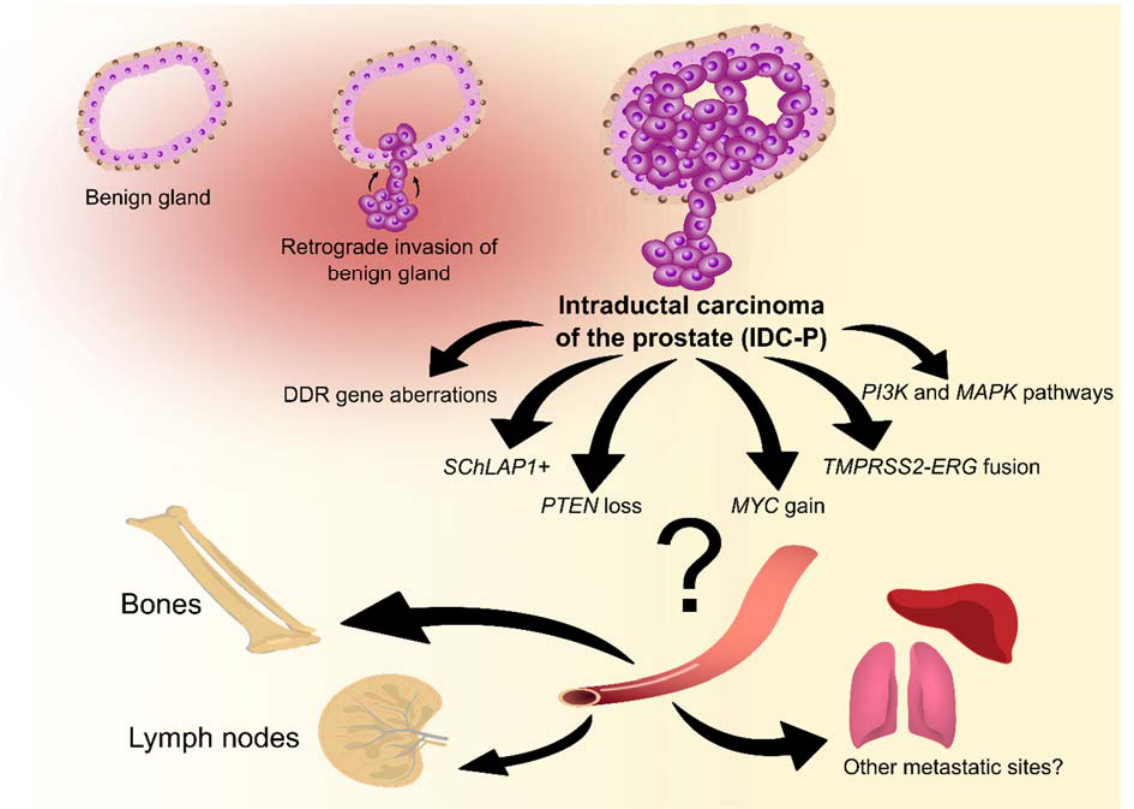
Figure 2. Known molecular alterations for the pathogenesis and progression of intraductal carcinoma of the prostate (IDC-P). DDR: DNA-damage repair; SChLAP1 : second chromosome locus associated with prostate cancer-1; PTEN : phosphatase and tensin homolog; ERG : ETS-related gene; PI3K: phosphoinositide 3 ‐ kinase; MAPK : mitogen ‐ activated protein kinase.